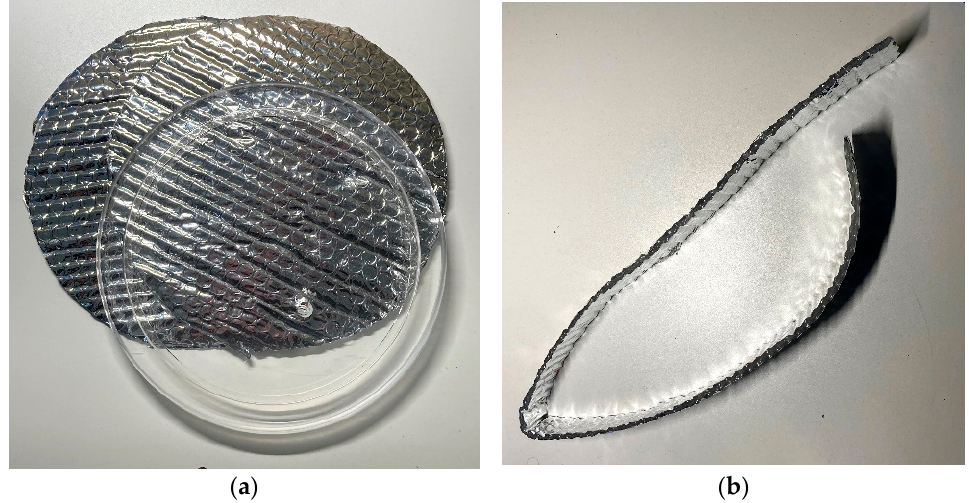
Figure 1. Insulation was cut to fit the specific vacuum chamber that was purchased. ( a ) Circles of insulation to cover the base and lid; ( b ) a strip of insulation to be wrapped around the circumference of the chamber to build an air gap.